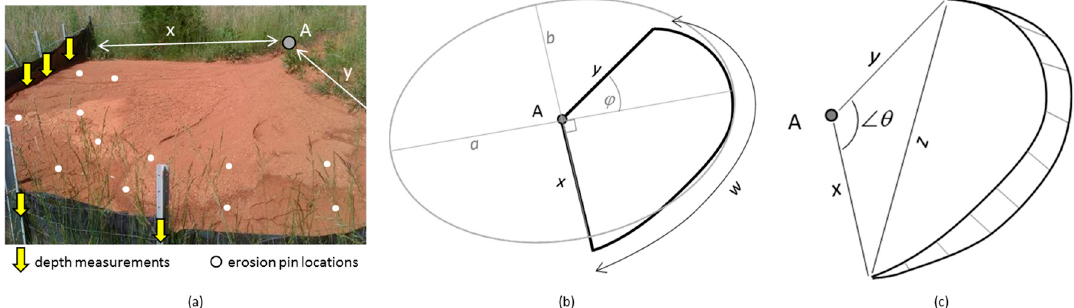
Figure 3. Delta area ( a ) was approximated by delineating the depositional zone, fitting an ellipse to the silt fence boundary, and summing the area of the delta sectors overlapping the lower and upper right quadrants of the ellipse ( b ). Wedge angle θ was calculated using the law of cosines ( c ).